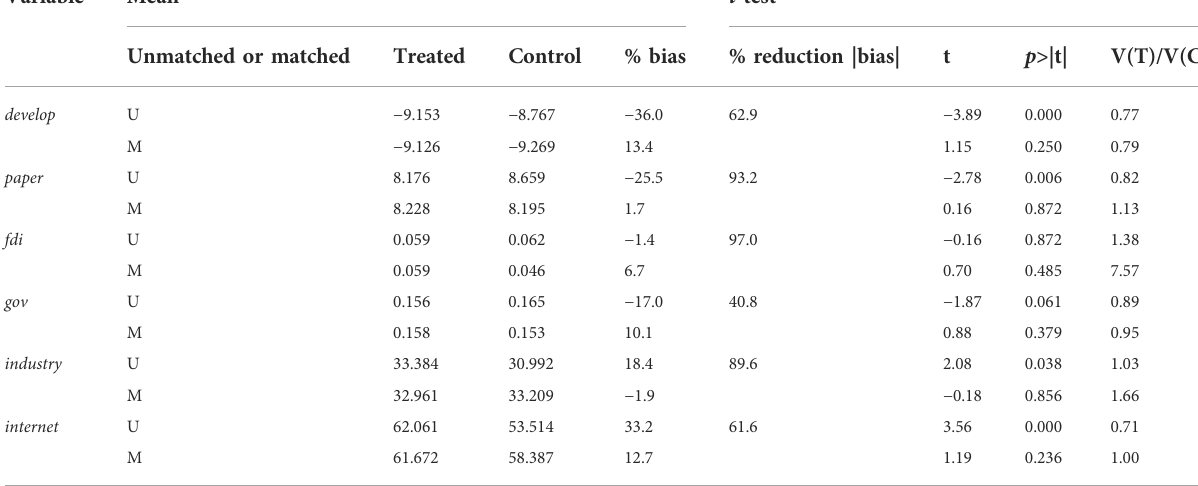
TABLE 3 Results of the balance